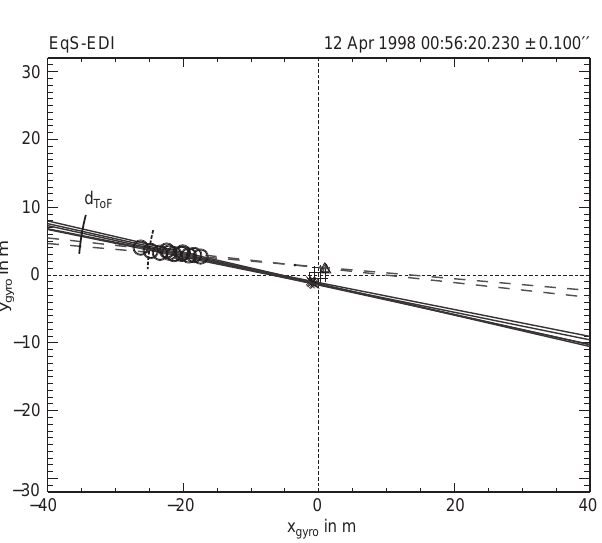
Fig. 7. A third comparison of triangulation and time-of-flight results, for a triangulation drift step of only (20 (cid:6) 5)m that just overlaps with the drift step derived from the di(cid:128)erence in averaged times-of-flight, (35 (cid:6) 10)m, of which only the average, labeled d ToF and the lower error bound are shown. The magnetic field was 40 nT at this